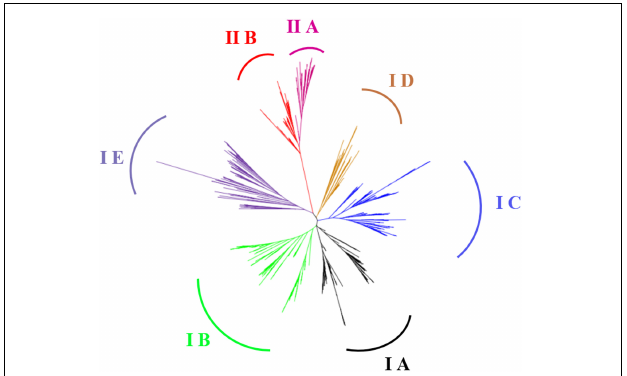
FIGURE 1 | Phylogenetic analysis of LBD proteins in 16 plant species. In total, 788 full-length amino acid sequences in LBD proteins were aligned with Clustal X. Phylogenetic tree was constructed with ML (maximum-likelihood) method in MEGA X and 100 times of bootstrap replicates. Different subgroups in the phylogenetic tree are labeled with different